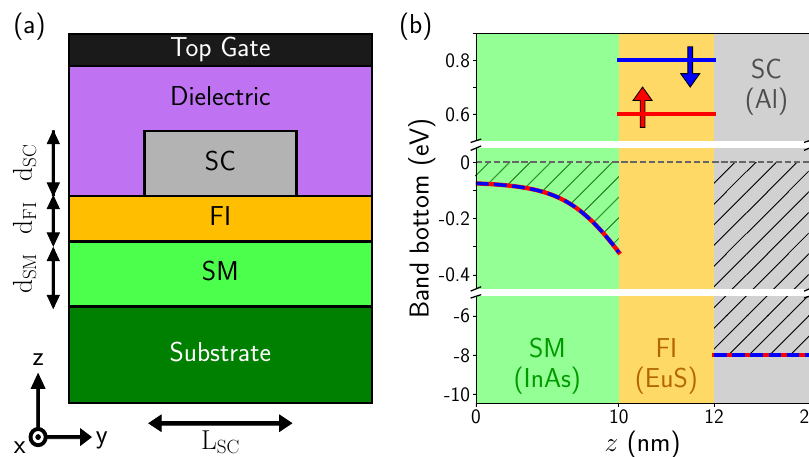
Fig. 1 Hybrid planar heterostructure. a Sketch of the device studied in this work: 2D semiconductor (SM)/ferromagnetic insulator (FI)/ superconductor (SC) heterostructure stacked in the z -direction and in fi nite in the x -direction. The substrate is insulating and typically composed of several stacked semiconducting layers. The top gate can be used to con fi ne the wavefunction below the grounded SC. The thickness of the ferromagnetic insulator layer d FI is varied to optimize the topological properties. b Schematics of the conduction-band bottom along the heterostructure stacking direction for a speci fi c choice of materials (InAs/EuS/Al) and representative geometrical parameters (